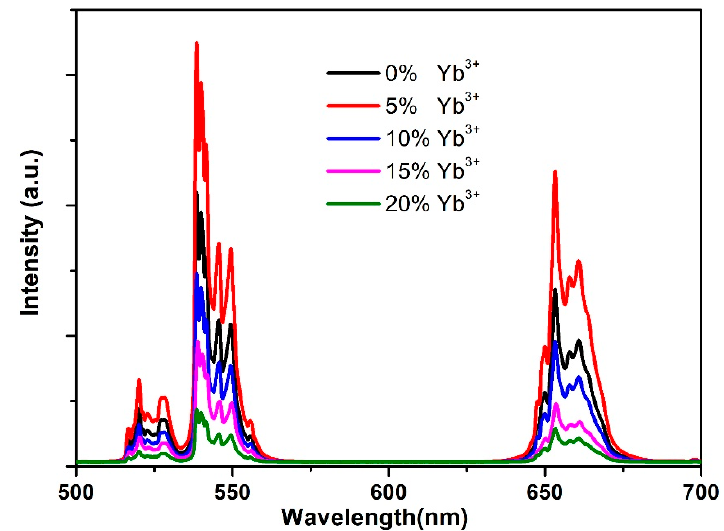
Figure 6. The UC emission spectrum of NaYF 4 :Yb 3+ ,Er 3+ @NaYF 4 :x%Yb 3+ nanocrystals with different Yb 3+ concentrations.